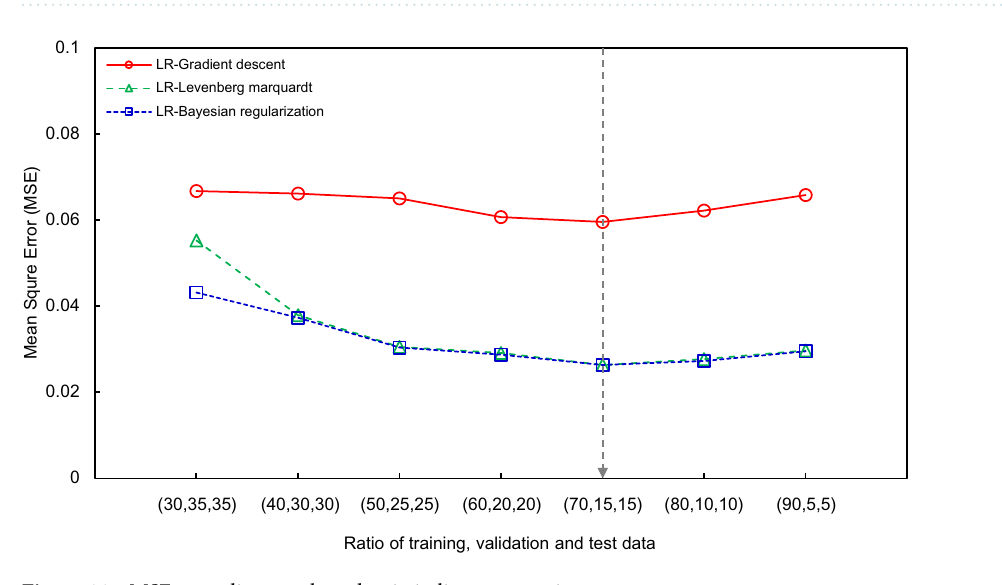
Figure 10. Flow chart of linear regression and the neural network.